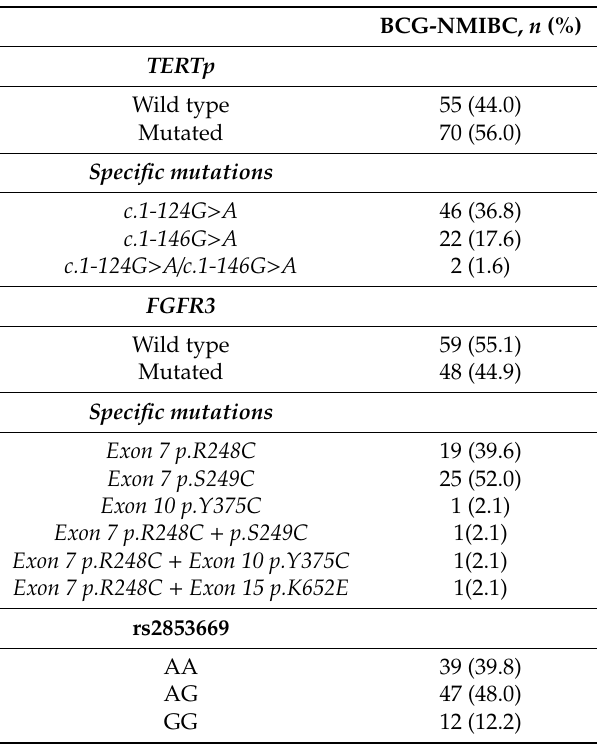
Table 1. Telomerase reverse transcriptase gene promoter ( TERTp ) mutations, Fibroblast Growth Factor Receptor 3 ( FGFR3 ) mutations, and rs2853669 prevalence across BCG-treated cases of nonmuscle invasive bladder cancers